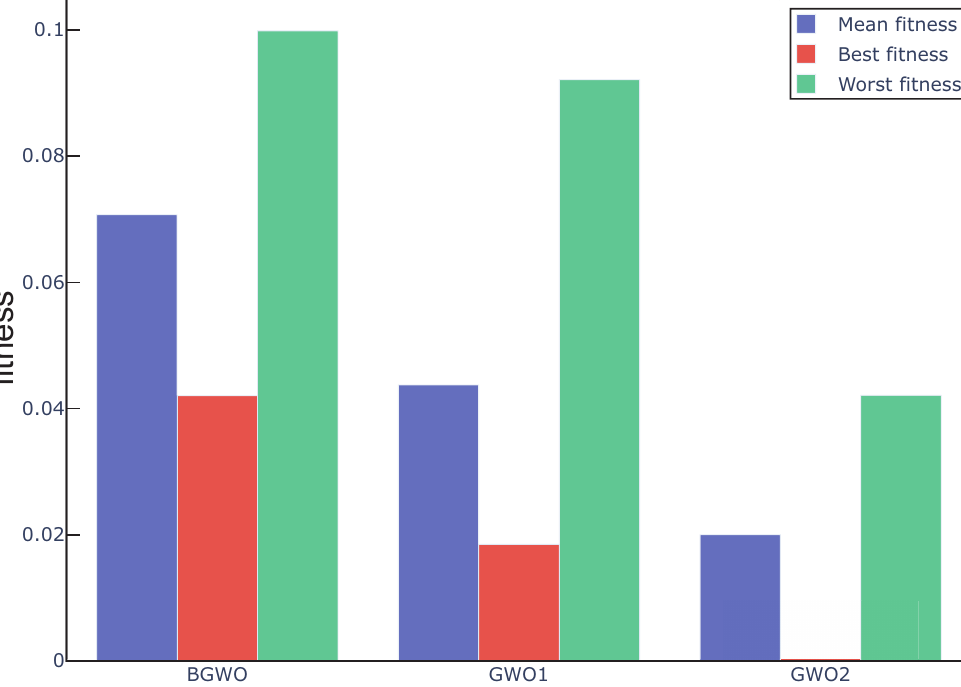
Figure 4. Mean, best, and worst fitness obtained from different algorithms over